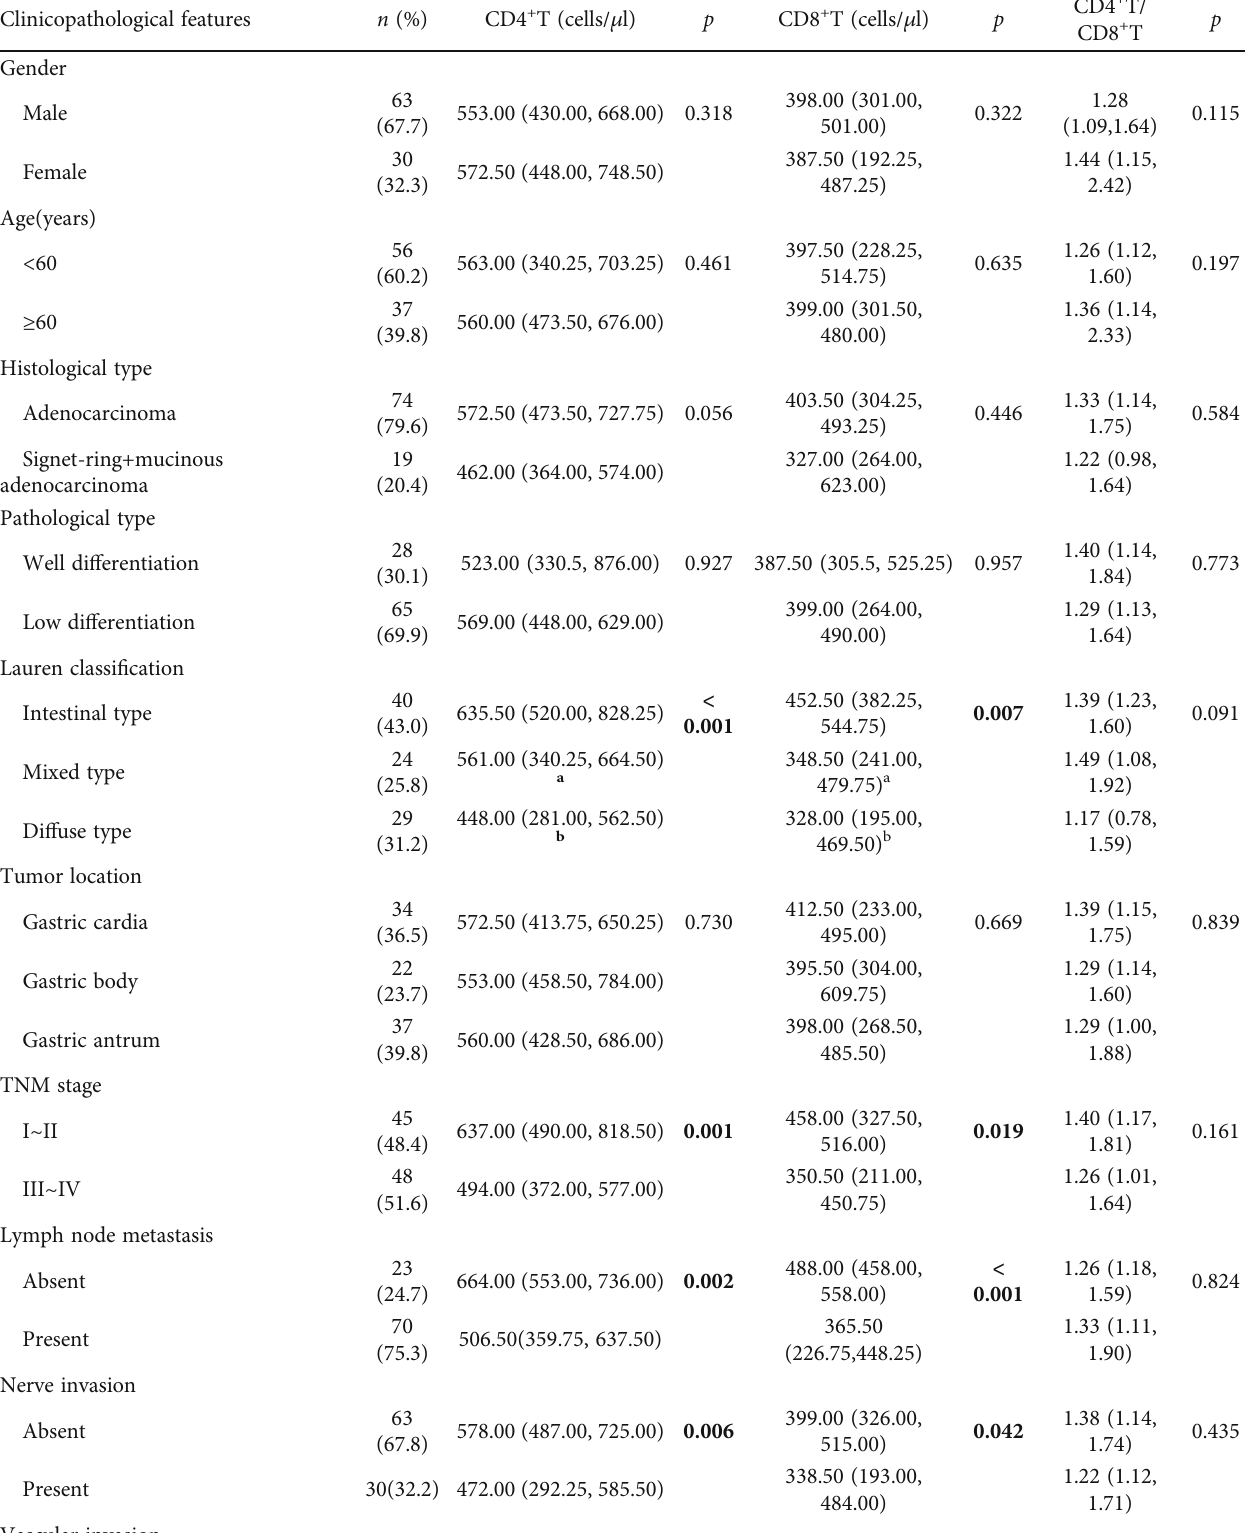
Table 1: Relationship between the number of CD4 + T and CD8 + T cells in peripheral blood and clinicopathological features in GC patients (M (P25 and